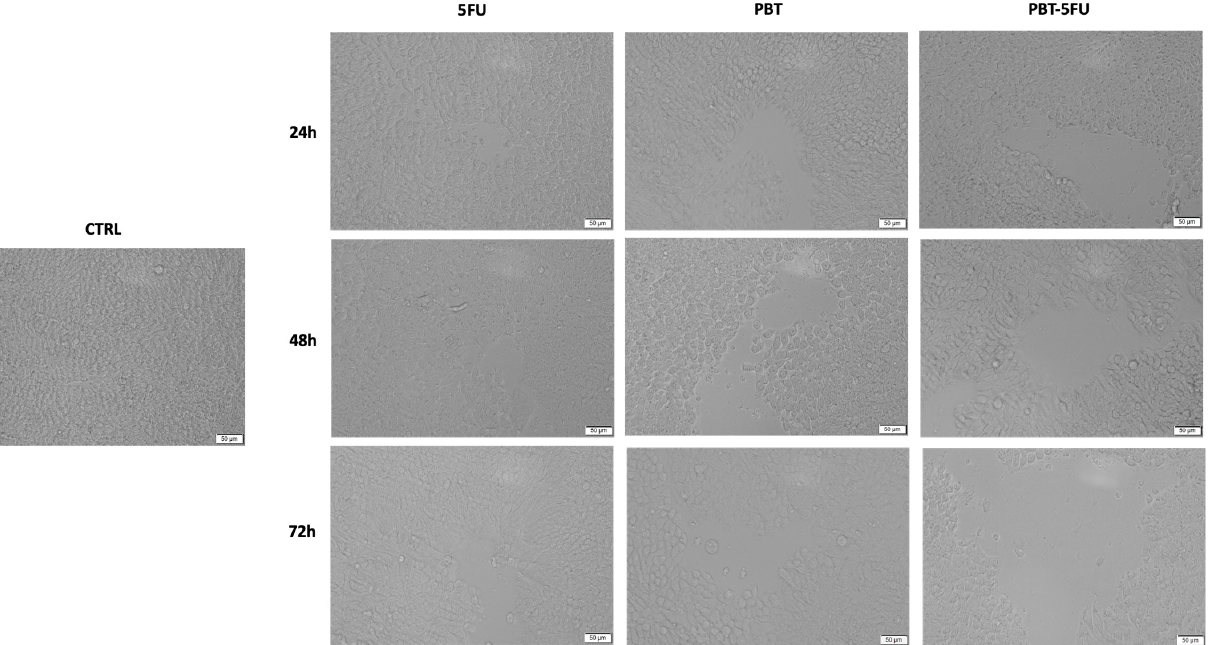
Figure 3. Morphological and shape changes produced by 5FU, PBT and PBT-5FU in HT-29 cells after 24, 48, and 72 h of treatment. The scale bars indicate 50 µm. Cell morphology changes were recorded after treatment with 5FU at all three time intervals, including the rounding of cells and a decrease in confluency, with the most sig- nificant changes occurring after 72 h. Similarly, PBT induced significant cell morphologi- cal alterations at all three time intervals, but especially after 72 h. Interestingly, PBT-5FU